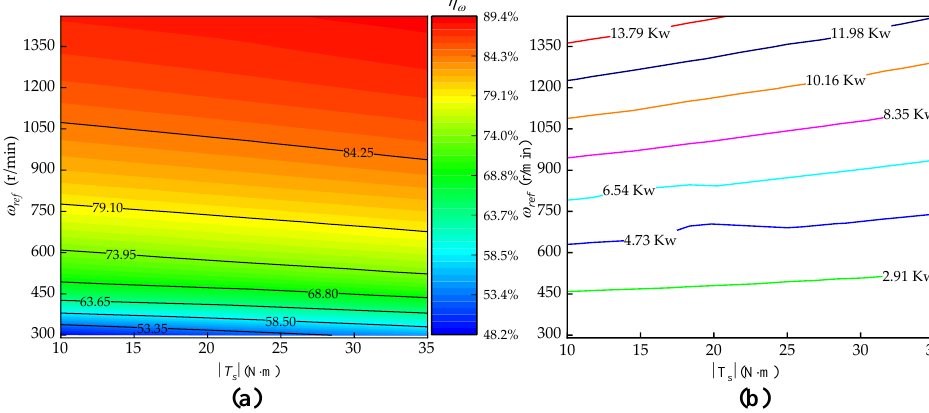
Figure 10. ( a ) Speed accuracy map for T-CBV system, ( b ) power consumption map for T-CBV sys- tem.